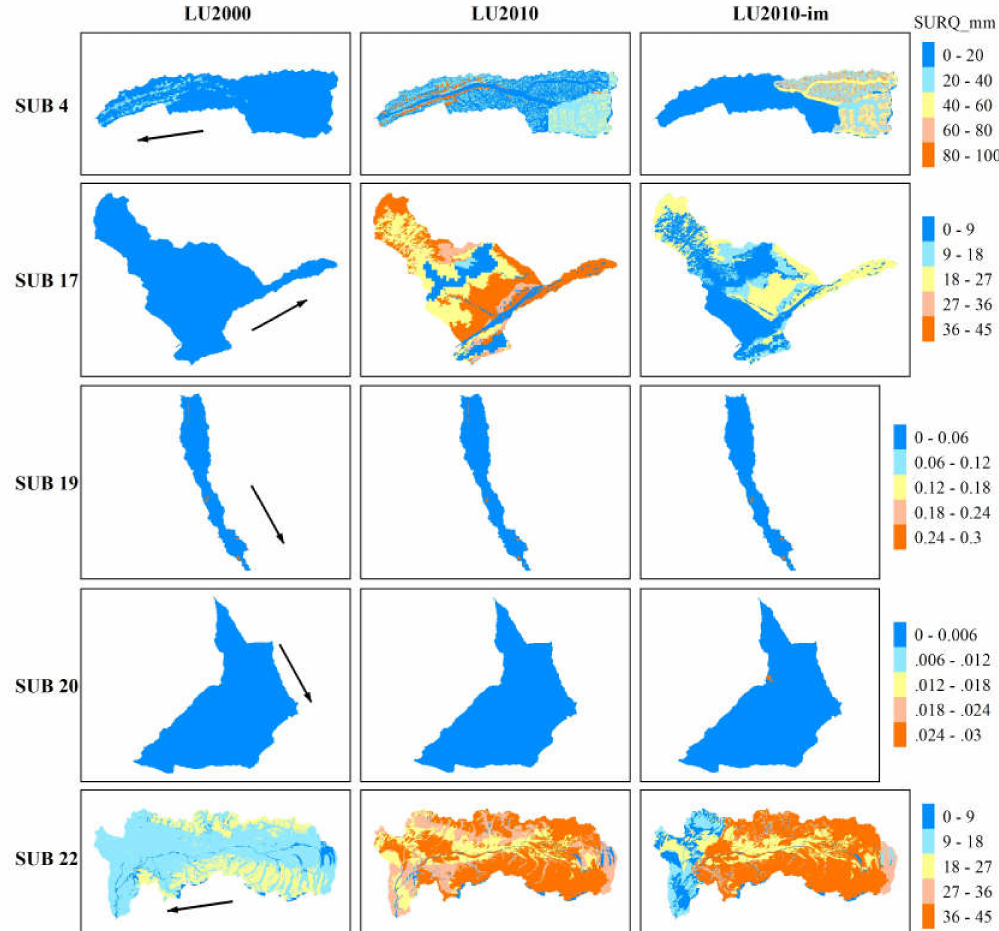
Figure 9. Spatial distribution of surface runoff (mm/month) at the HRU level in April (mean 2002–2007) for the LU2000, LU2010, and LU2010-im models in sub-basins. The arrow indicates the flow